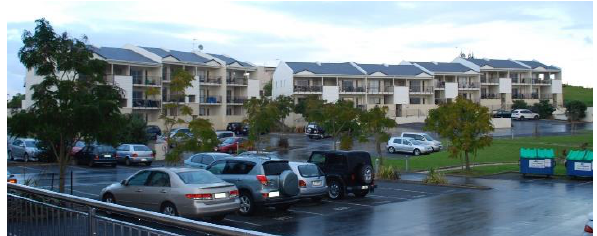
Figure 6. Internal view of the Albany case study development. The photograph shows the extent of surface car parking and poorly positioned waste disposal facilities (source: